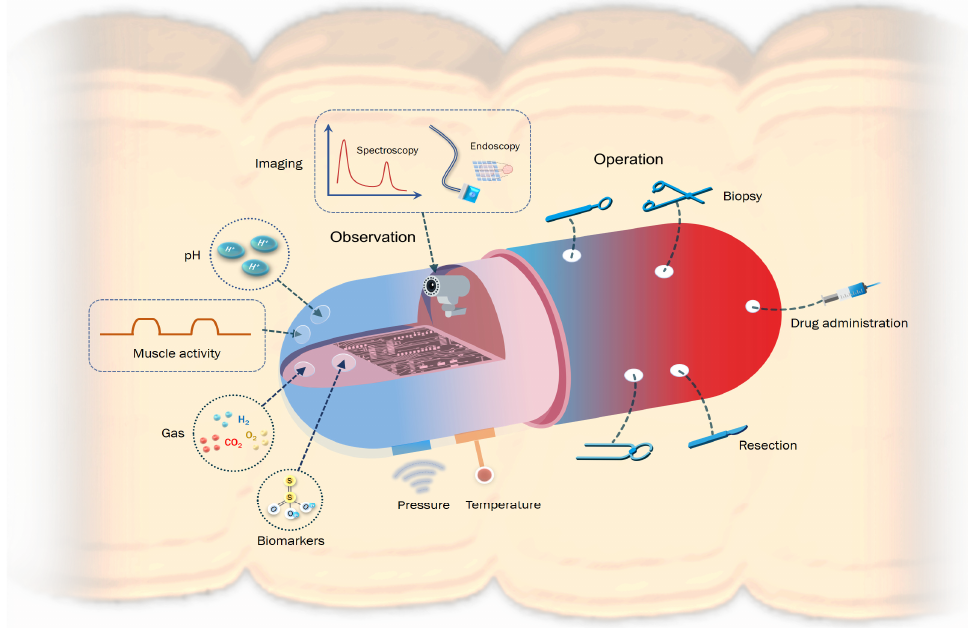
Figure 2. Schematic representation of ingestible sensor model working as a sensing and operational device for healthcare.